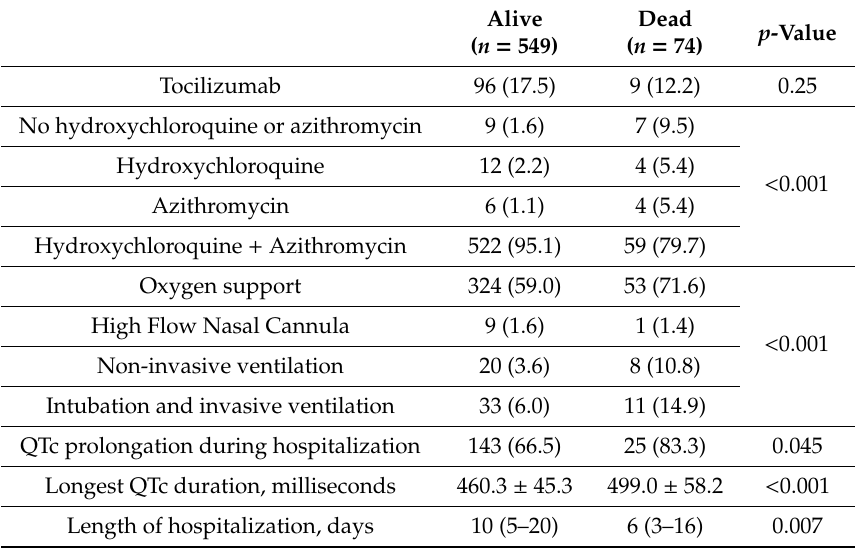
Table 5. Comparison of in-hospital treatment and outcomes between patients alive and dead during